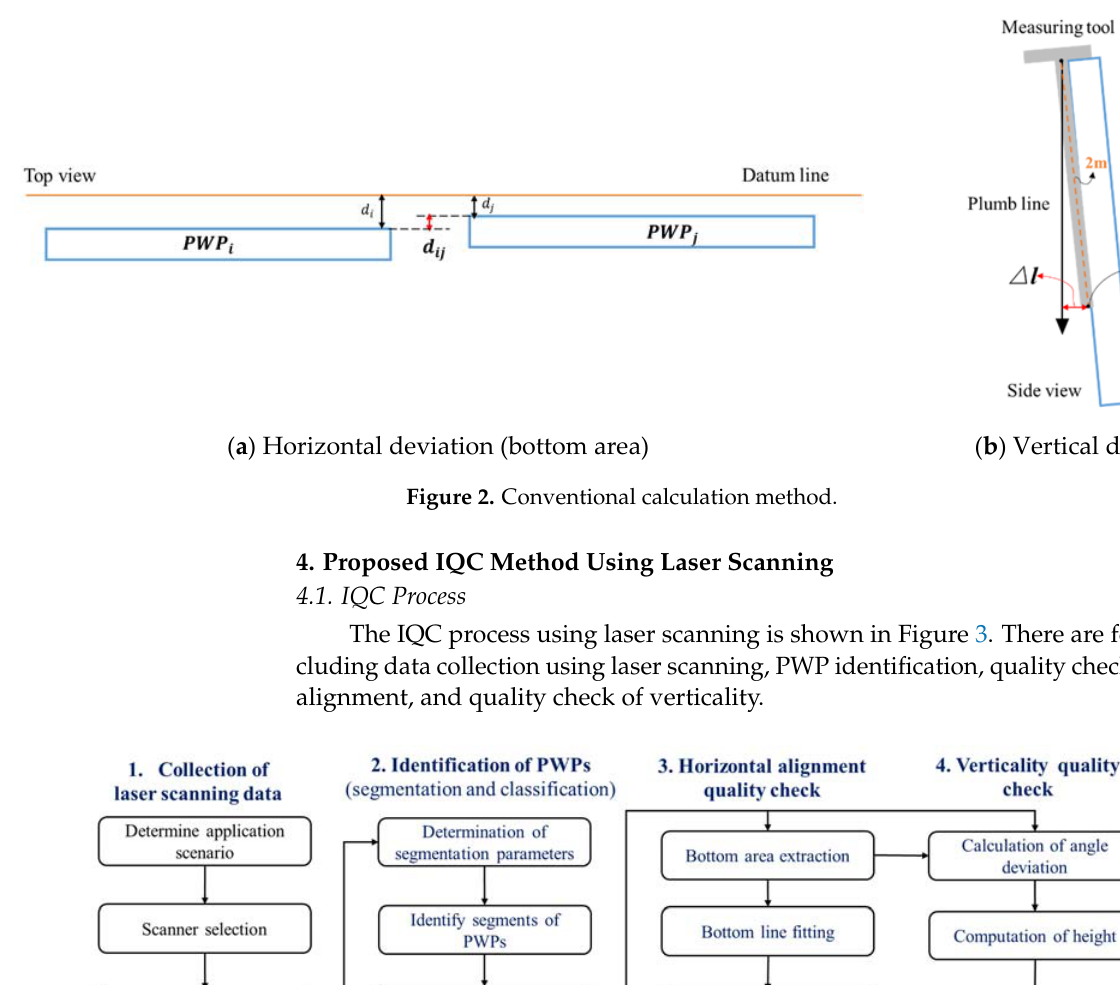
Table 2. Technical characteristics of the BLK 360 laser scanning device.